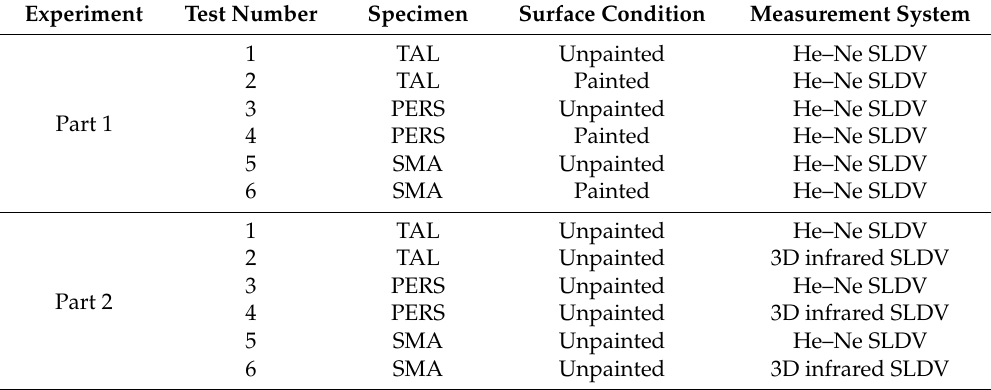
Table 2. Second experiment: modal analysis of three different specimens with different surface conditions and different measurement systems.